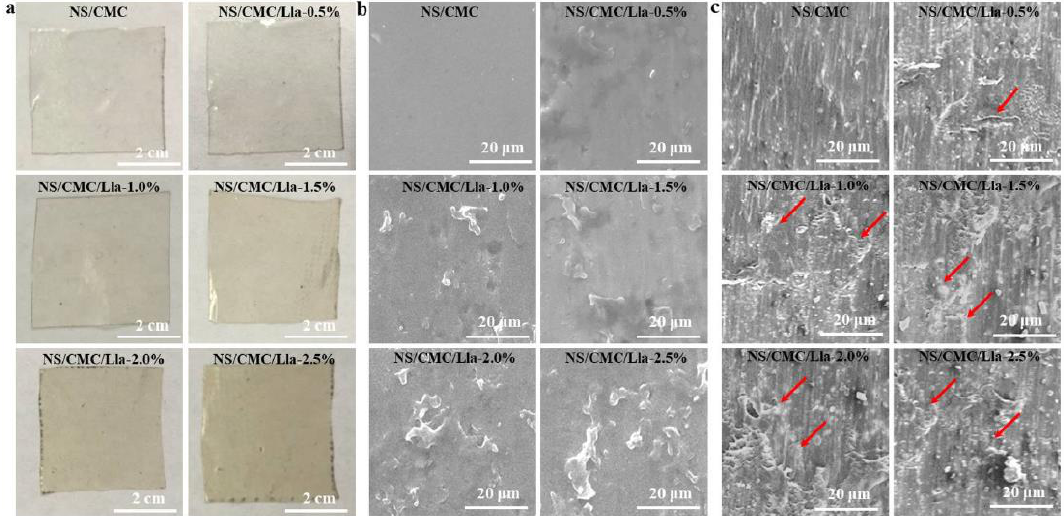
Figure 4. ( a ) Digital photos, ( b ) SEM images, and ( c ) cross-section images of NS (Corn Starch)/Carboxymethyl cellulose (CMC) with 0%, 0.5%, 1.0%, 1.5%, 2.0% and 2.5% Lactococcus lactis . Reproduced with permission from [15]. (Copyright 2021 Elsevier).